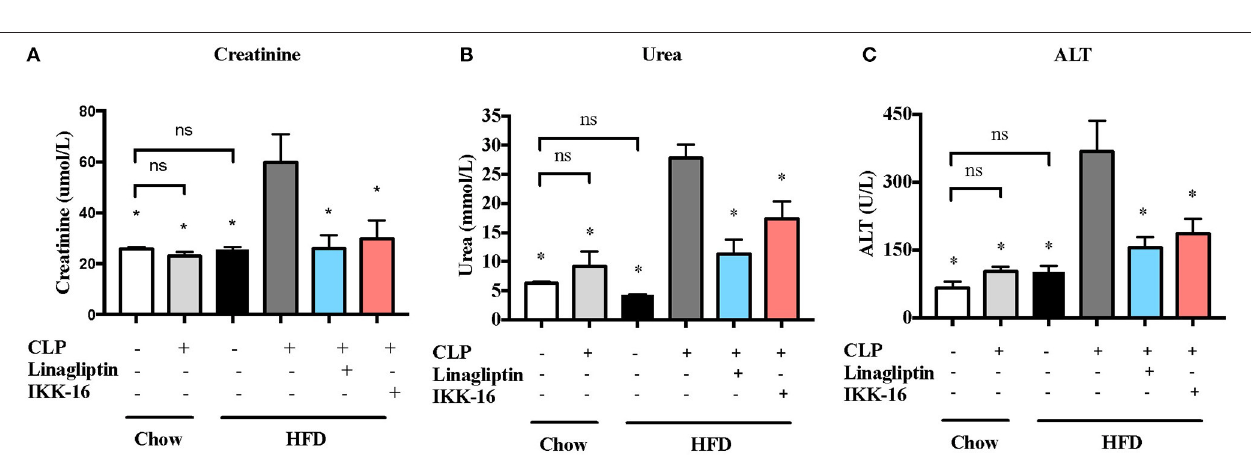
FIGURE 6 | Effects of CLP and linagliptin or IKK-16 post treatment on renal dysfenction and hepatocelleular injury in mice with pre-existing T2DM. Mice from chow and HFD groups were randomized to undergo CLP or sham surgery. At 1h after CLP, mice on HFD were randomized to receive linagliptin (10 mg/kg, i.v.), IKK-16 (1 mg/kg, i.v.), or vehicle (2% DMSO, 3 ml/kg). At 24h after CLP, blood samples were collected and serum (A) urea, (B) creatinine, and (C) ALT levels were measured. Data was analyzed using one-way ANOVA followed by Bonferroni’s post-hoc test and expressed as mean ± SEM. * P < 0.05 compared to HFD + CLP group. ( n = 8 per sham surgery group, n = 10 per CLP